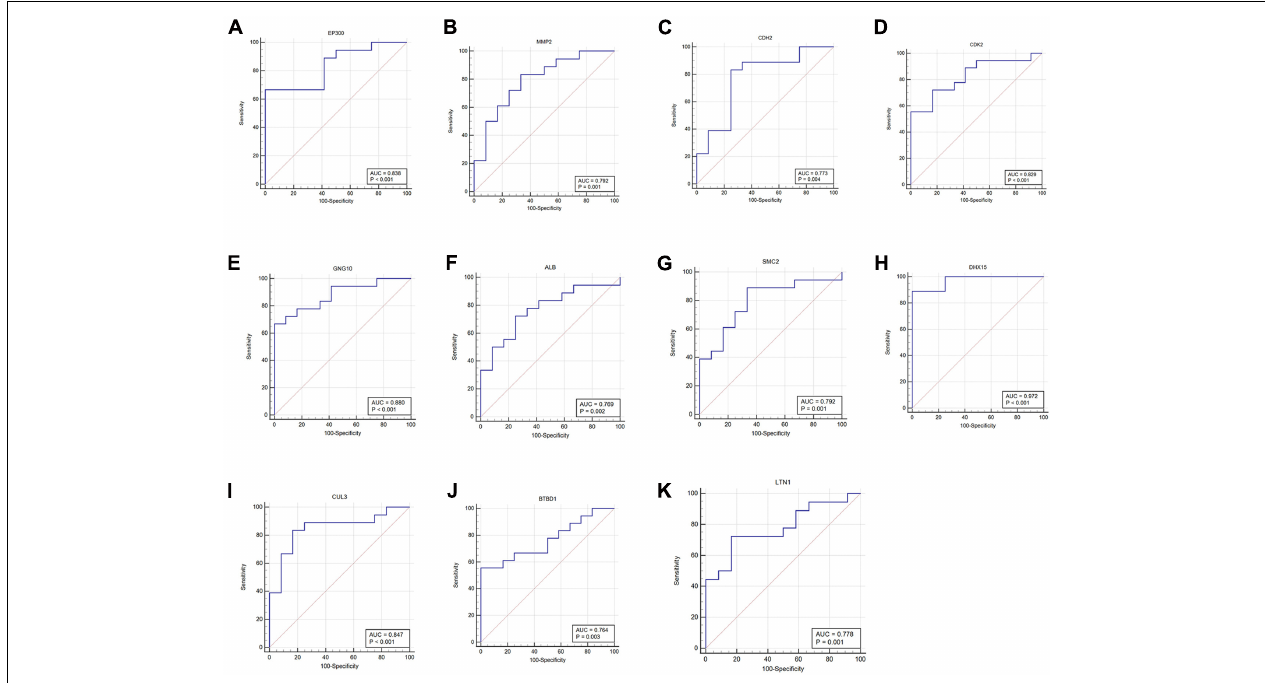
FIGURE 8 | ROC curves of the hub genes. (A) EP300 , (B) MMP2 , (C) CDH2 , (D) CDK2 , (E) GNG10 , (F) ALB , (G) SMC2 , (H) DHX15 , (I) CUL3 , (J) BTBD1 , and (K) LTN1 . ROC, receiver operating characteristic; EP300 , E1A binding protein p300; MMP2 , matrix metallopeptidase 2; CDH2 , cadherin 2; CDK2 , cyclin-dependent kinase 2; GNG10 , G protein subunit gamma 10; ALB , albumin; SMC2 , structural maintenance of chromosomes 2; DHX15 , DEAH-box helicase 15; CUL3 , cullin 3; BTBD1 , BTB domain containing 1; LTN1 , listerin E3 ubiquitin protein ligase 1.